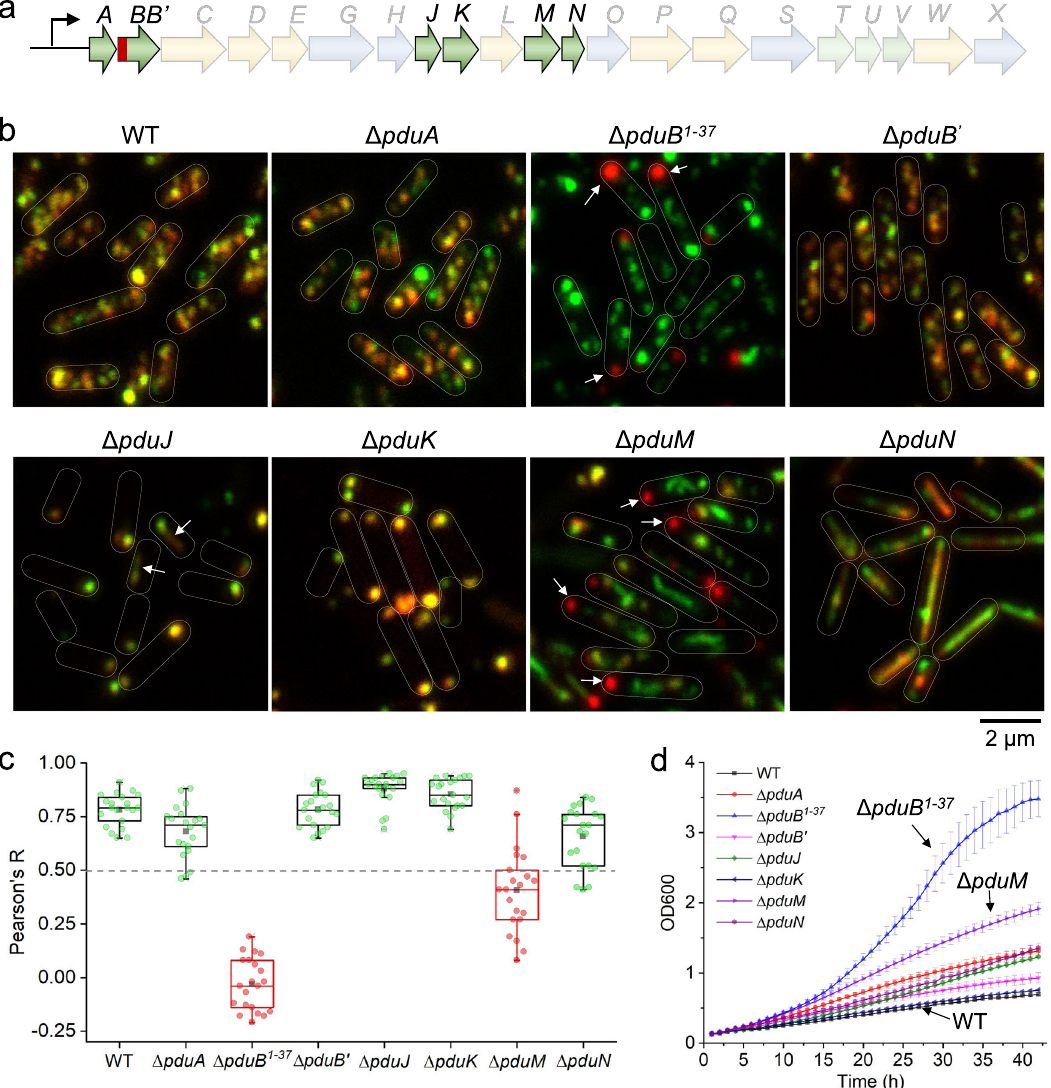
Fig. 2 Role of pdu shell gene products in Pdu BMC biogenesis. a Relevant shell-encoding genes of relevance to ( b – d ) are highlighted in the context of the pdu operon of S . Typhimurium LT2. b PduA-sfGFP (green, PduJ-sfGFP for Δ pduA ) and PduE-mCherry (red) were visualized in WT and deletion mutants that lacked individual shell genes, following growth in MIM + 1,2-PD. c Colocalization analysis of sfGFP and mCherry fl uorescence in ( b ). A Pearson ’ s R value close to 1 re fl ects reliable colocalization, while values near zero indicate uncorrelated fl uorescence distributions. Shell (PduA) and cargo (PduE) were colocalized in all strains except the Δ pduB 1 – 37 and Δ pduM mutants. The Pearson ’ s R values for all strains were: 0.78 ± 0.07 (WT); 0.68 ± 0.12 ( Δ pduA ); − 0.04 ± 0.12 ( Δ pduB ); 0.78 ± 0.08 ( Δ pduB ’ ); 0.88 ± 0.07 ( Δ pduJ ); 0.86 ± 0.07 ( Δ pduK ); 0.42 ± 0.19 ( Δ pduM ); 0.66 ± 0.14 ( Δ pduN ). Data are represented as mean ± SD. Boxplot center lines correspond to the median value; upper and lower whiskers extend from the box to the largest or smallest value correspondingly, but no more than 1.5 times the interquartile range; mean values show as the square symbol. n = 20, n represents the number of cells. d Growth curves of WT S . Typhimurium LT2 and Pdu shell gene-deletion mutants on 1,2-PD with limiting B 12 (20 nM) in NCE medium (containing 0.6% 1,2-PD; 0.3 mM each of leucine, isoleucine, threonine, and valine; 50 μ M ferric citrate). Data are represented as mean ± SD. n = 4, n represents the number of biologically independent